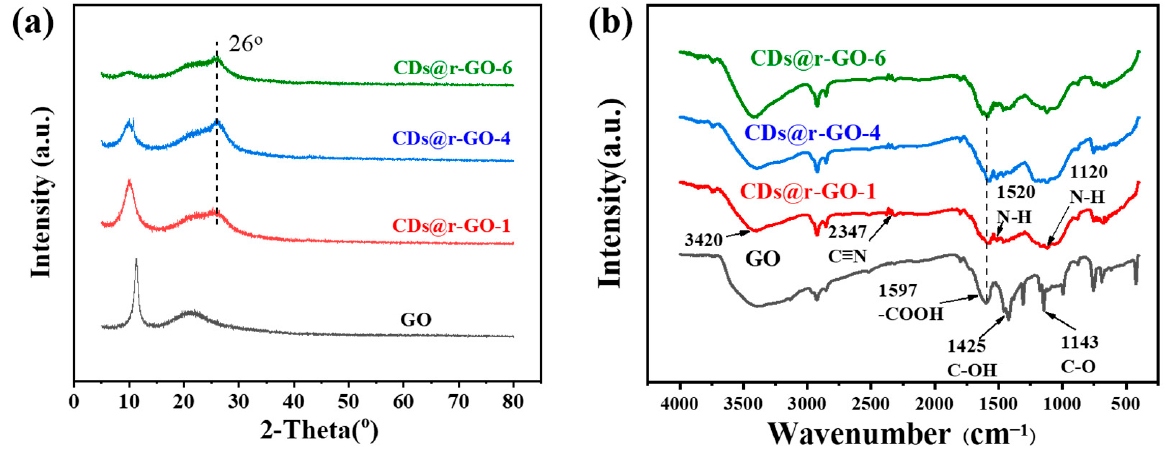
Figure 2. ( a ) X-ray diffraction patterns and ( b ) Fourier-transform infrared spectra of GO, CDs@r-GO-1, CDs@r-GO-4 and CDs@r-GO-6. Table 1. Analysis of elemental contents obtained by XPS.